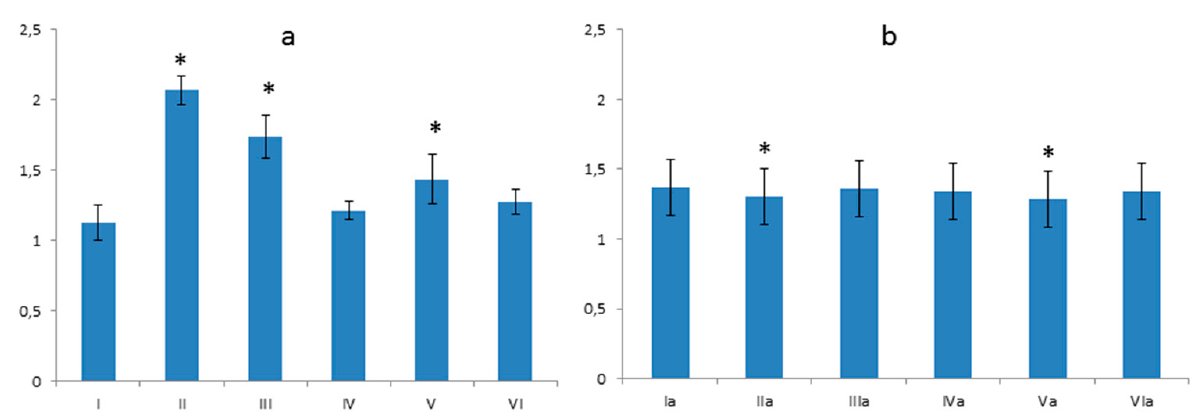
Figure 9. The ratio of the capsule surface to the capillary tuft surface in rats fed with regular diet ( a ). The ratio of the capsule surface to the capillary tuft surface in rats fed with a high-cholesterol diet ( b ). Differences were statistically significant in respect to the control group at p = 0.05 (and signed by *). Vertical scale units expressed in µm.